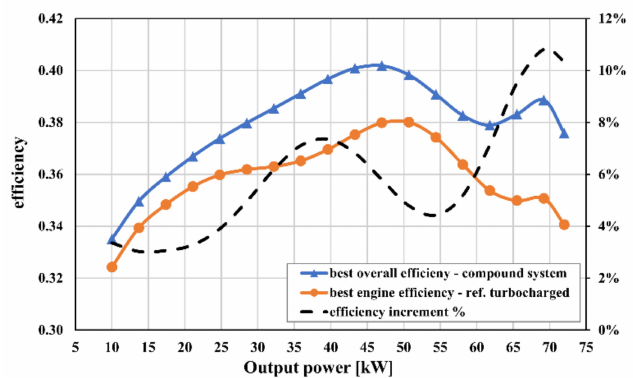
Figure 19. Comparison between the best efficiency curves of the compound engine with respect to the reference turbocharged engine ( T 4 /T 1 = 3.5 and η T = 0.70).